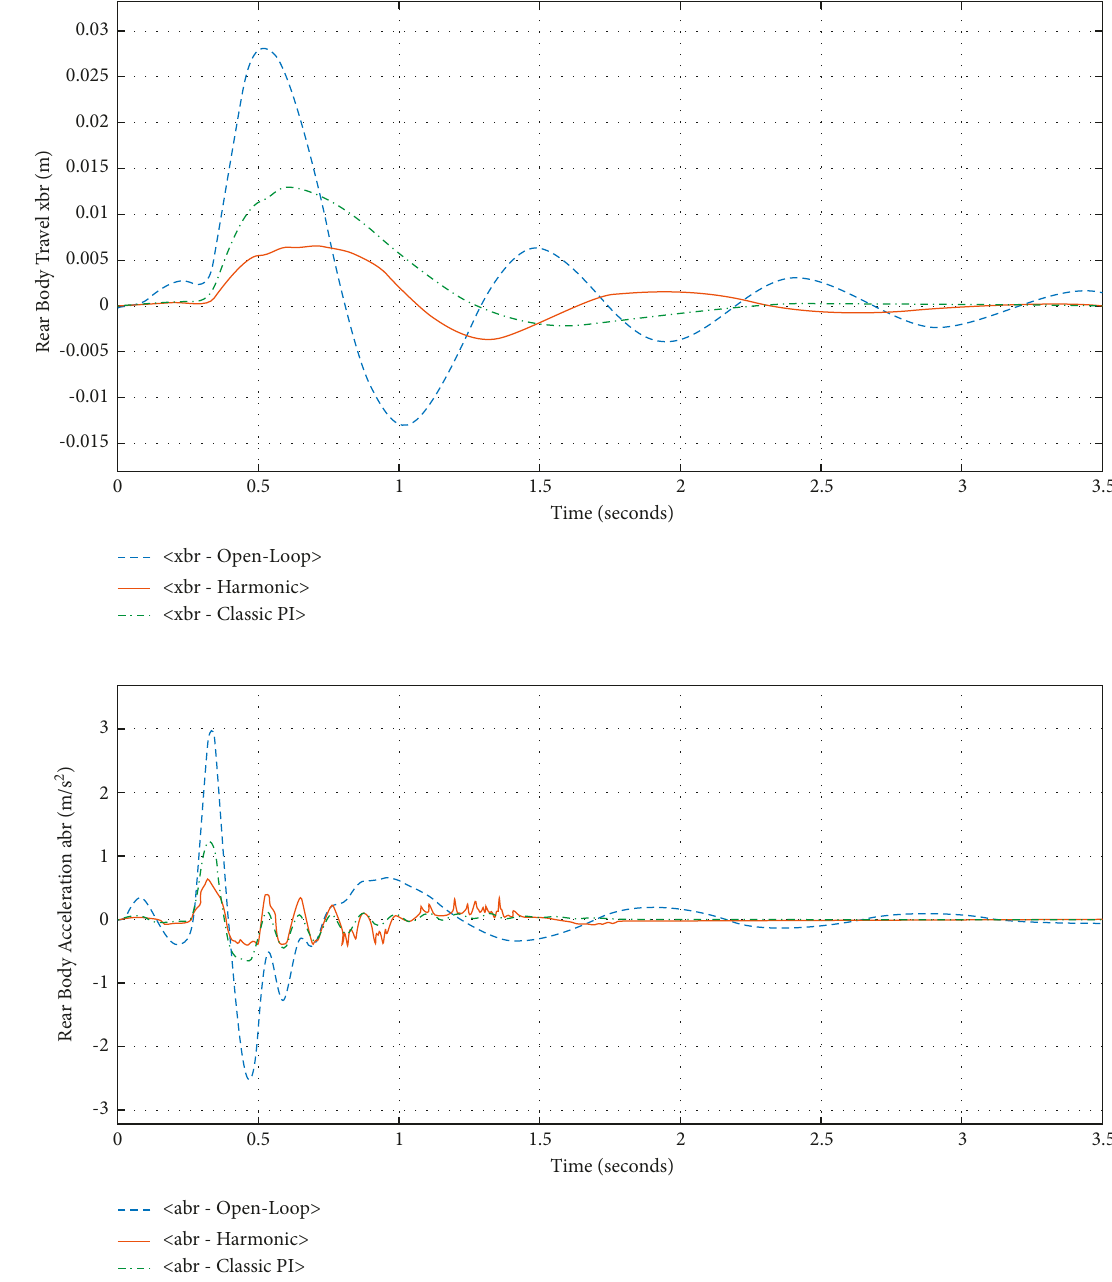
Figure 7: Rear body travel x a br and rear body acceleration br results: blue dash line means open-loop, red continuous line means harmonic, and green dash line means classic